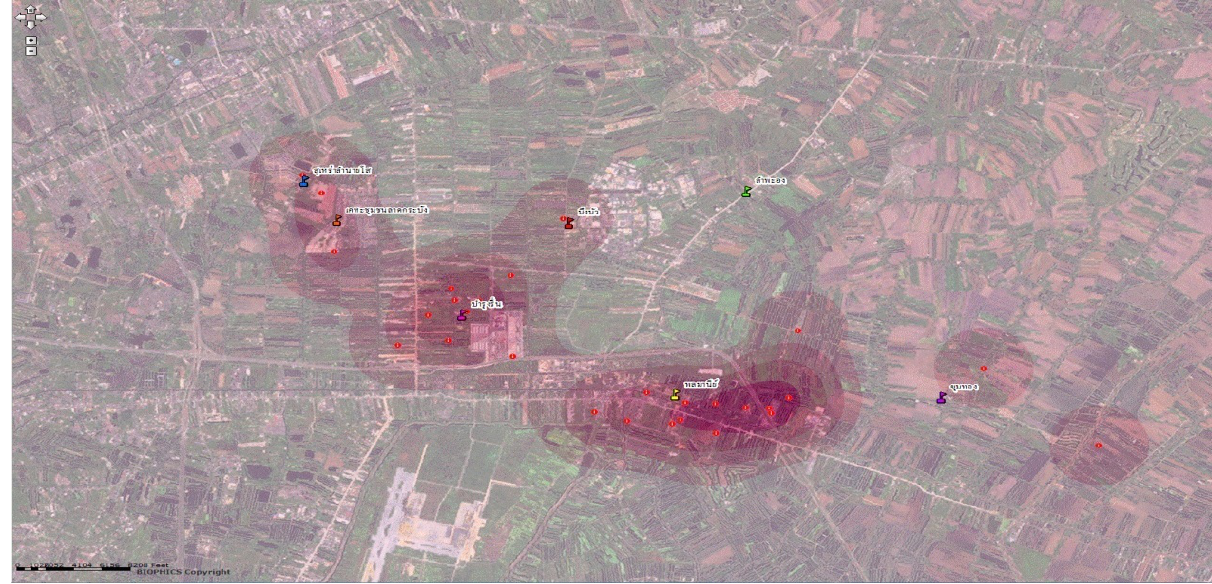
Figure 7. Clusters of school absentees, generated by the school absenteeism reporting system.